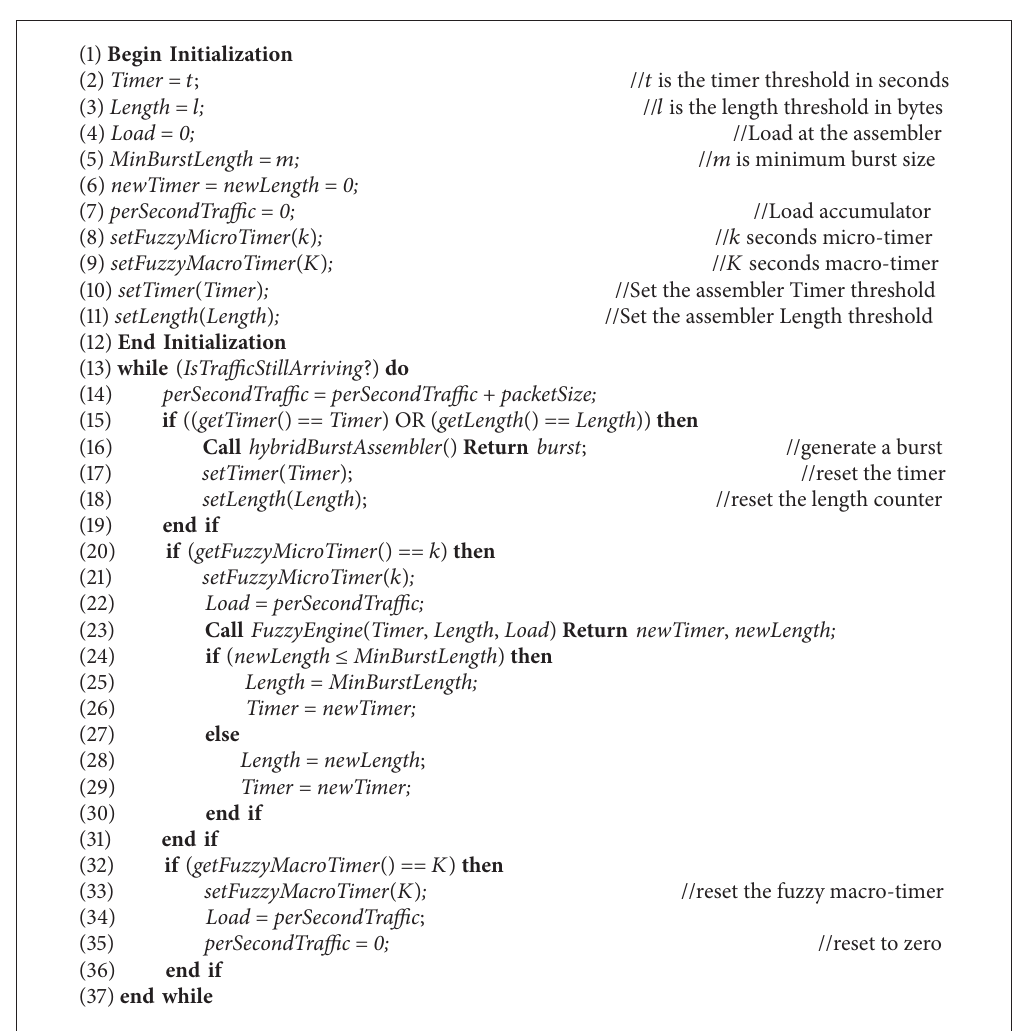
Algorithm 1: Fuzzy-based adaptive hybrid burst assembly (FAHBA)